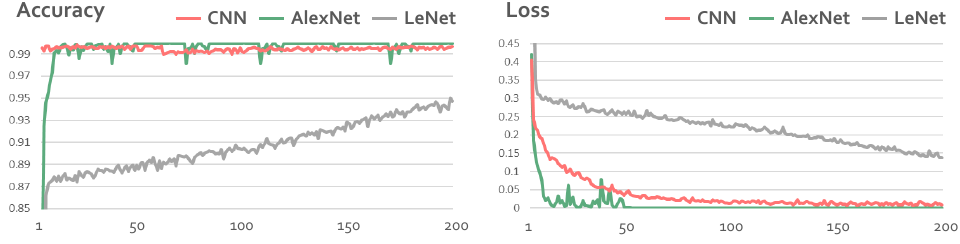
Figure 8. Accuracy, loss, and one epoch training mean time performance comparisons of CNN, AlexNet, and